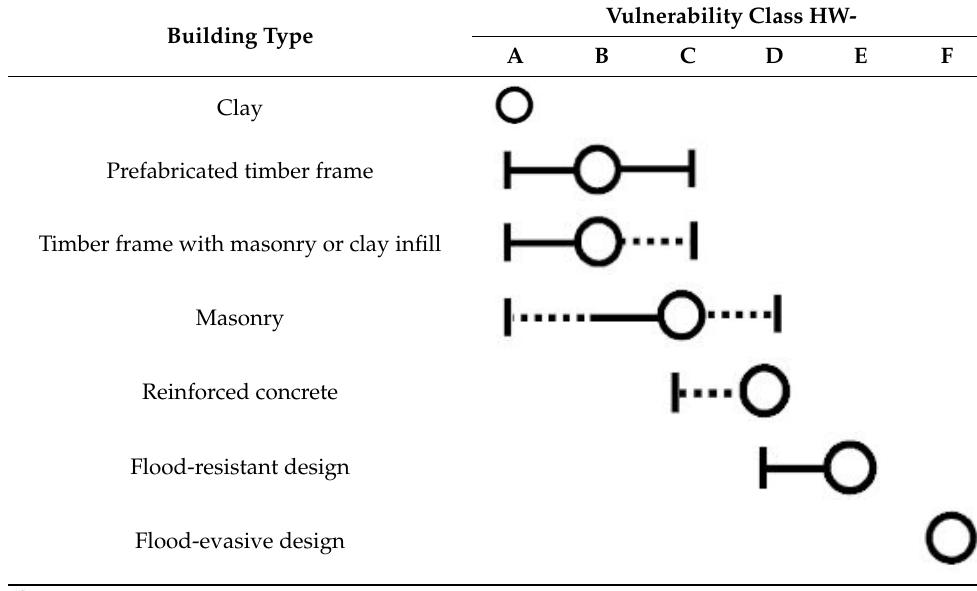
Table 4. Classification of building types in vulnerability classes and identification of ranges of scatter